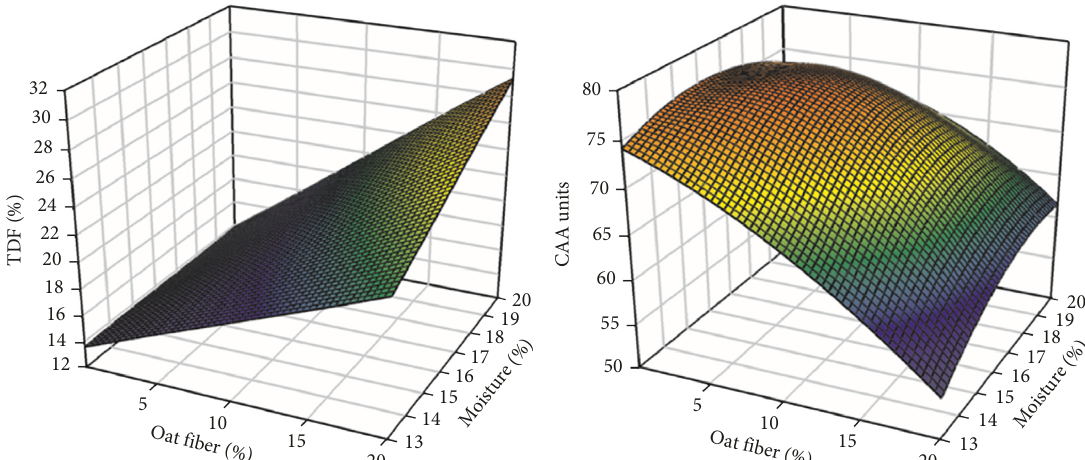
Figure 3: Effects of supplementation with different levels of oat fiber and tempering moisture contents (%) on total dietary fiber (TDF) and cellular antioxidant activity (CAA) of the collets made from oca flour.